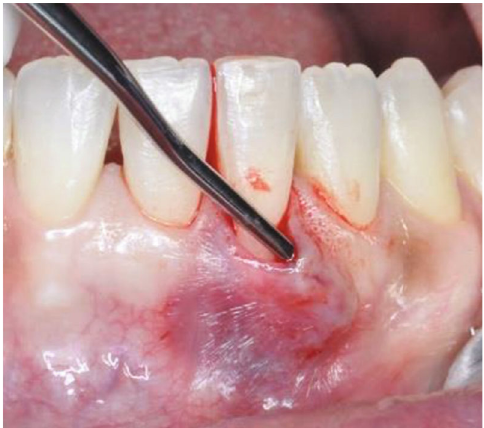
Figure 4: Detachment of the periosteal mucosa with no tensioned tissue.